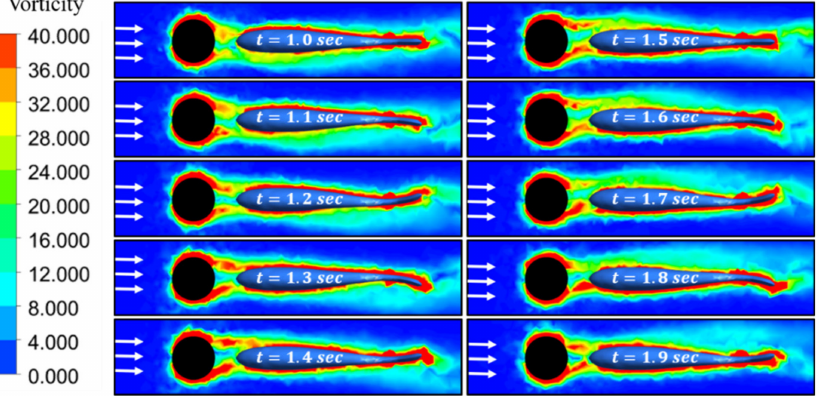
Figure 12. Snapshots of the vorticity field with TLC oscillating at 4 Hz behind the